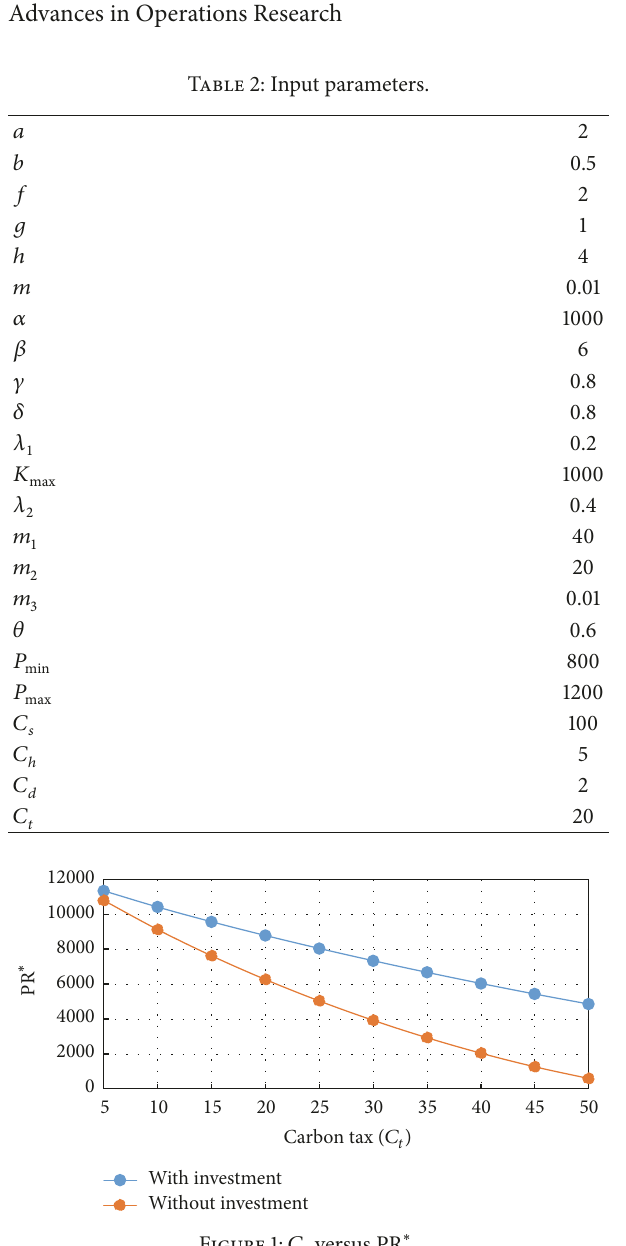
Figure 1: 𝐶 𝑡 versus PR ∗ .